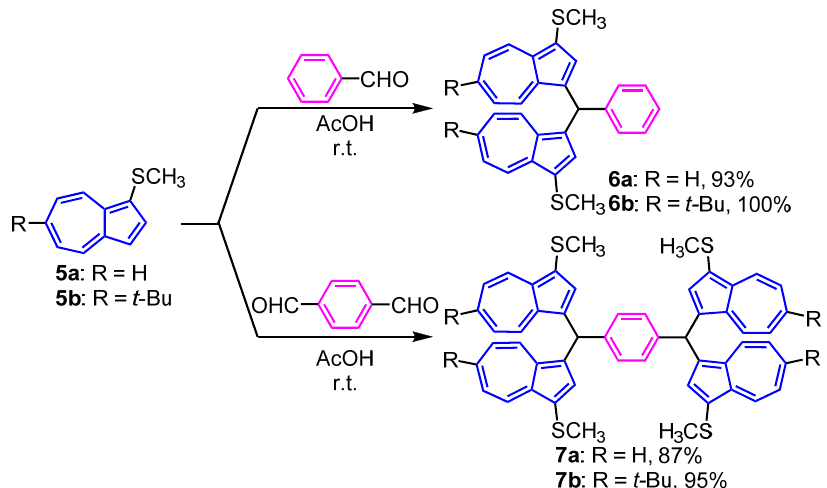
Figure 2. Synthesis of 6a , b and 7a , b from 1-methylthioazulenes 5a , b